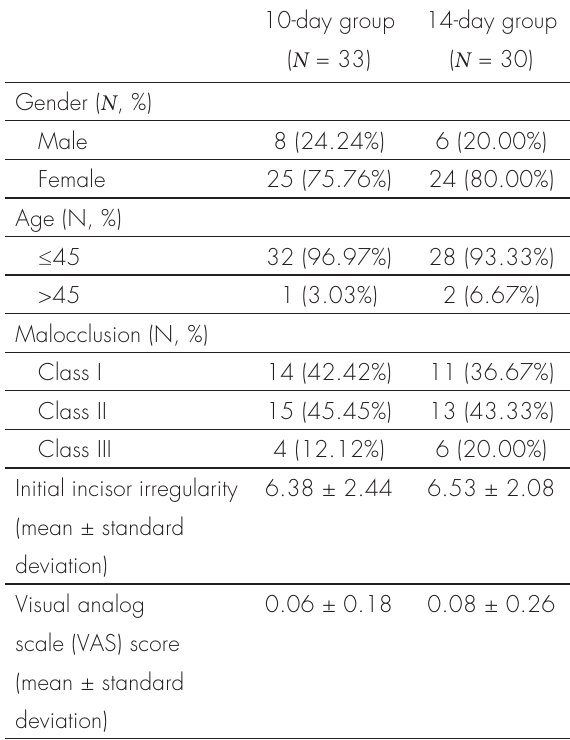
Table I. Baseline characteristics of participants included in the final